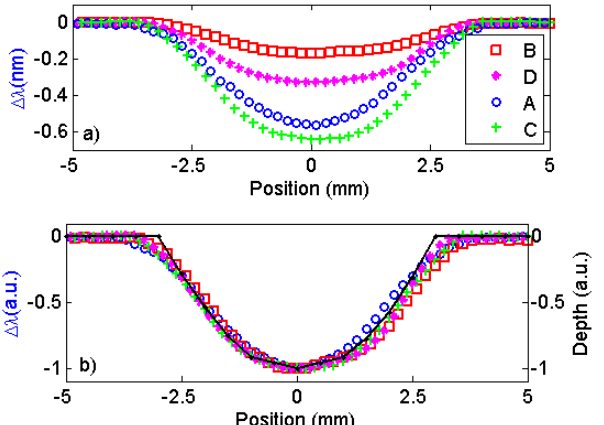
Figure 8. Change in the Bragg wavelength as the plate containing a fabricated semi-spherical corrosion pit is scanned under the FBG sensors. ( a ) Sensor A has a magnet 5.0 mm long with radius 1.0 mm (squares). Sensor B has a magnet 5.0 mm long with radius 1.5 mm (circles). Sensor C has a magnet 10 mm long with radius 1.0 mm (diamonds). Sensor D has a magnet 10 mm long with radius of 1.5 mm (crosses); ( b ) Normalized wavelength change and depth profile (solid line) versus distance. The scans were performed on a line passing over the center of the